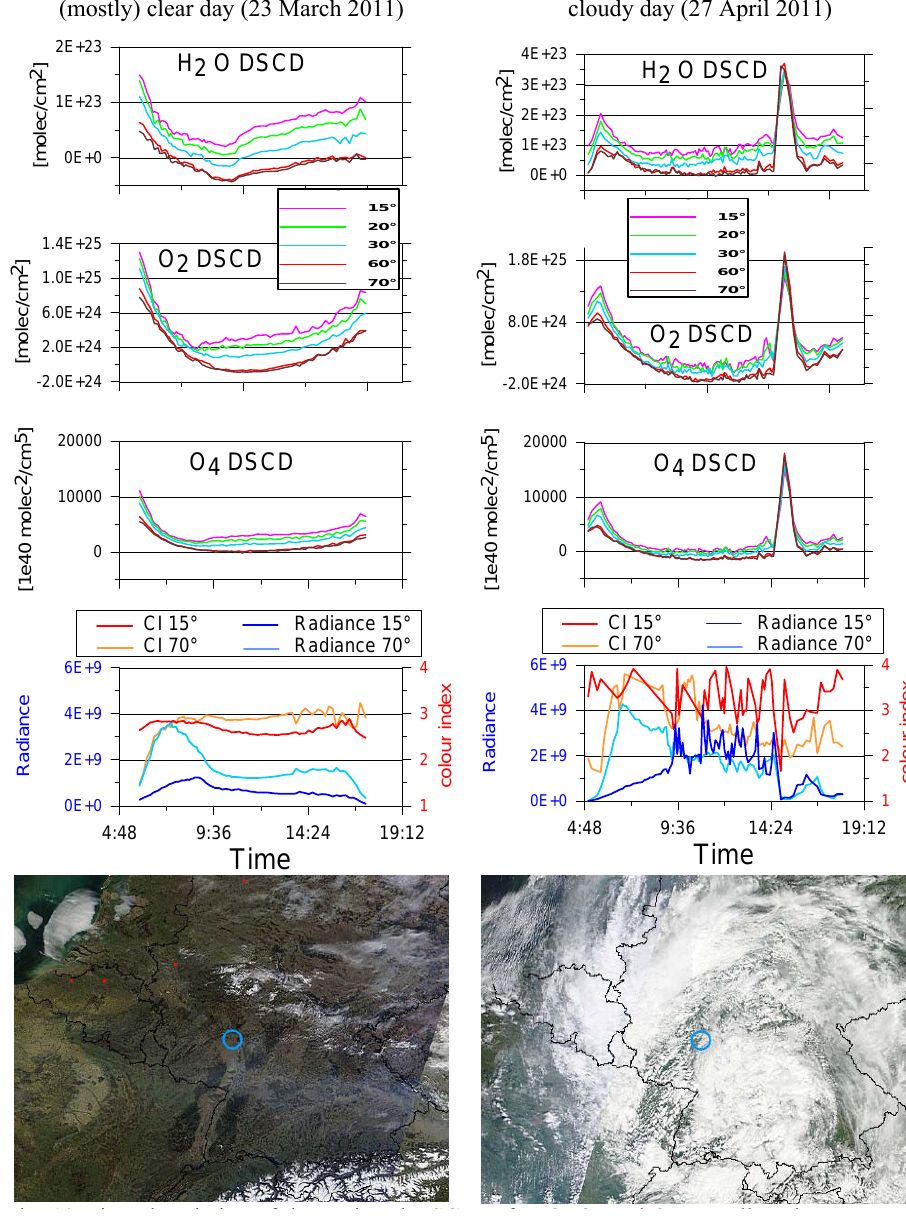
Fig. 10. Diurnal variation of the retrieved DSCDs of H 2 O, O 4 and O 2 as well as the measured (relative) radiance and colour index for a mostly clear day (23 March 2011, left) and a mostly cloudy day (27 April 2011, right). In the bottom, satellite images from the MODIS instrument are shown. Note that for the DSCDs of H 2 O and O 2 different y-scales for both days are used. The MODIS overpass times are 23 March 2011 at 11:00LT; 27 April 2011 at 09:55LT. (AERONET Data synergy tool, http://aeronet.gsfc.nasa.gov/cgi-bin/bamgomas_interactive)